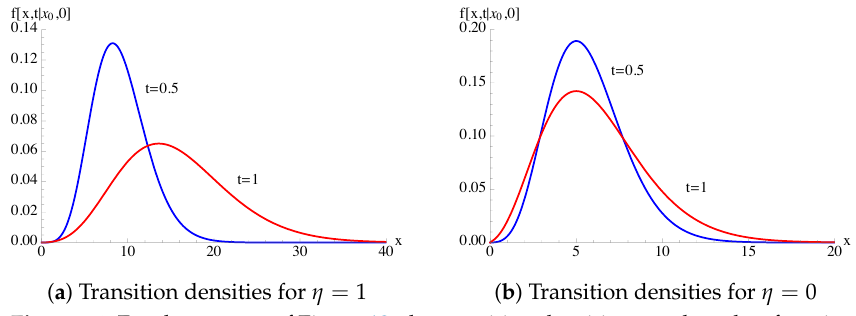
Figure 14. For the process of Figure 12, the transition densities are plotted as function of x .